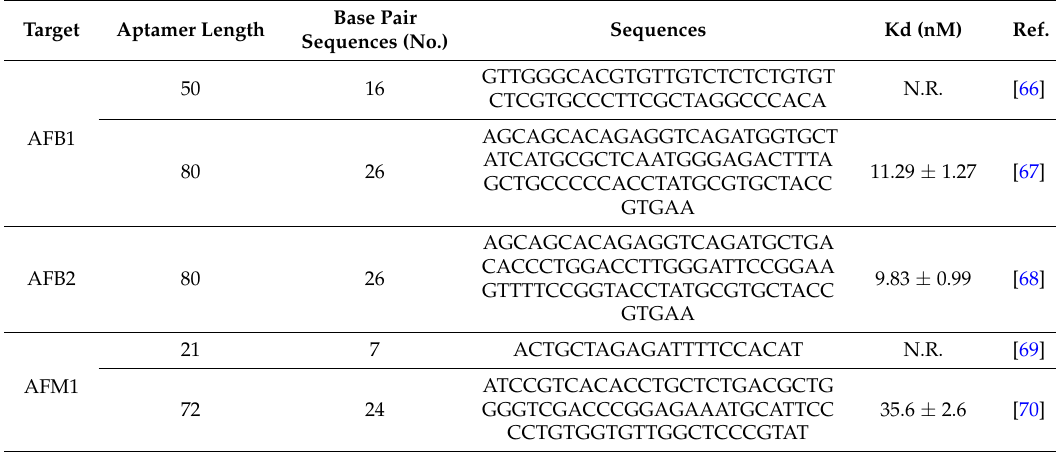
Table 3. Aptamer sequences for aflatoxins